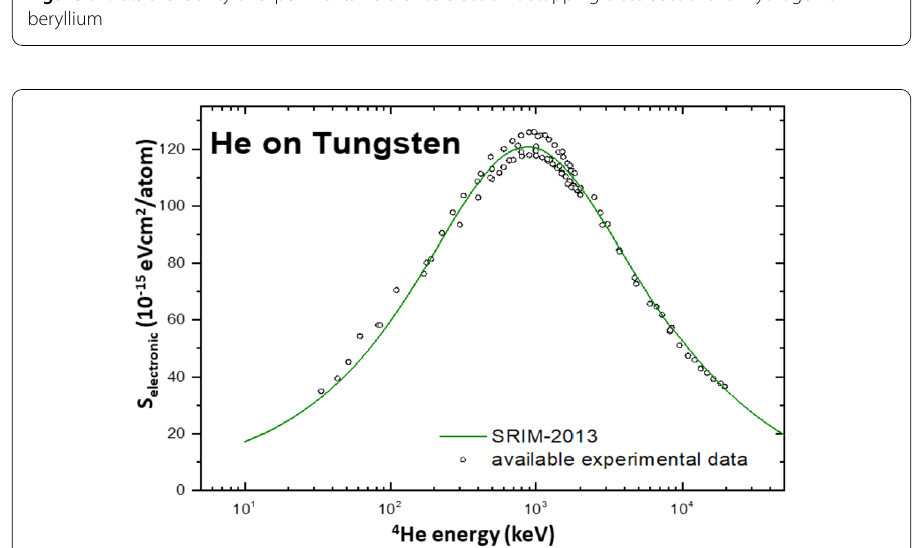
Figure 7 Data availability on experimental reference electronic stopping cross-sections for helium-4 on